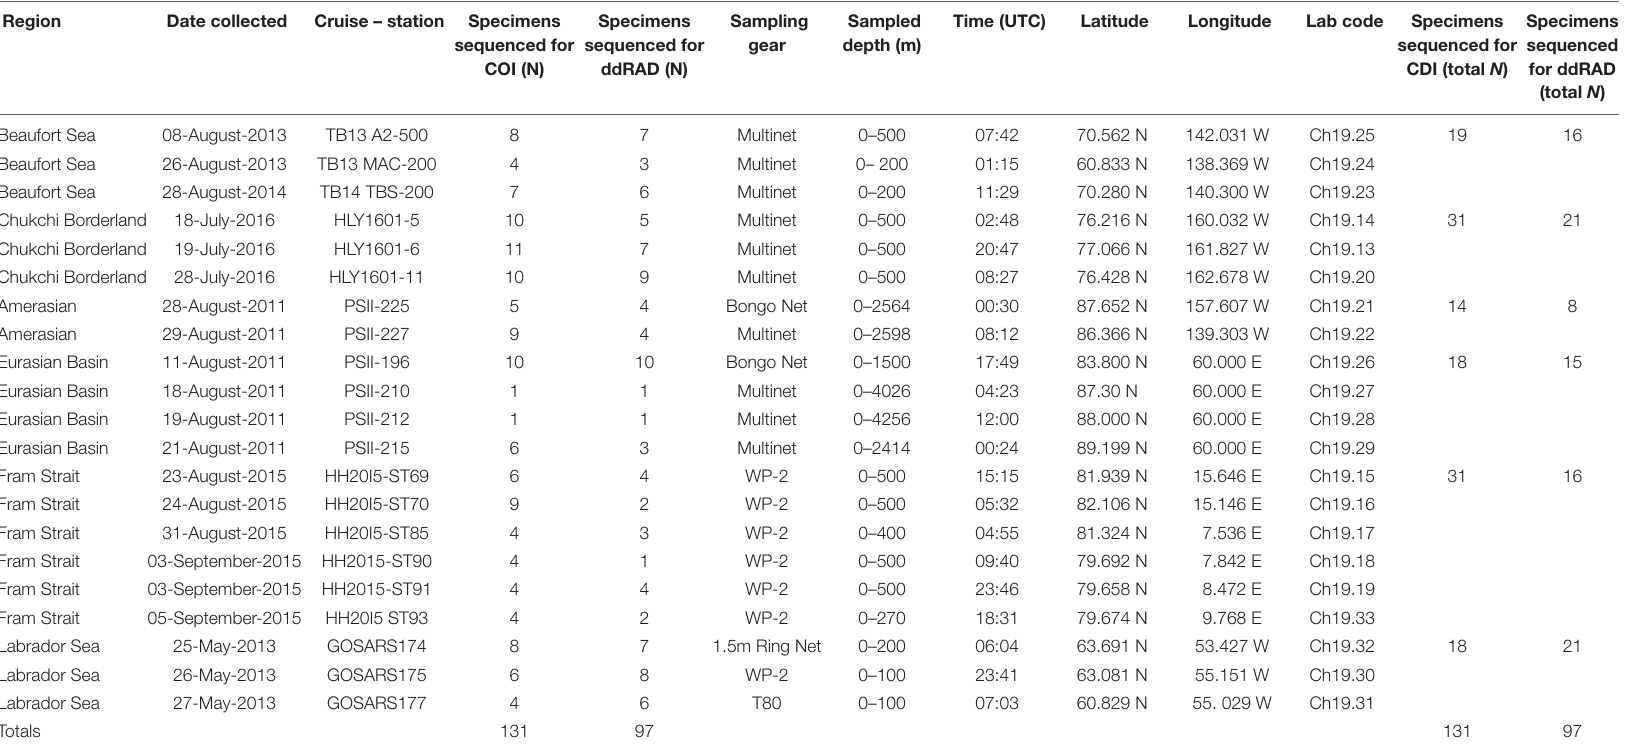
TABLE 1 | Collection metadata for samples from which specimens of Eukrohnia hamata were identified for analysis in this